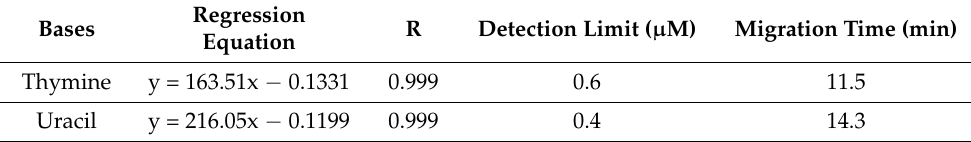
Table 1. Detection limits and linearity for thymine and uracil